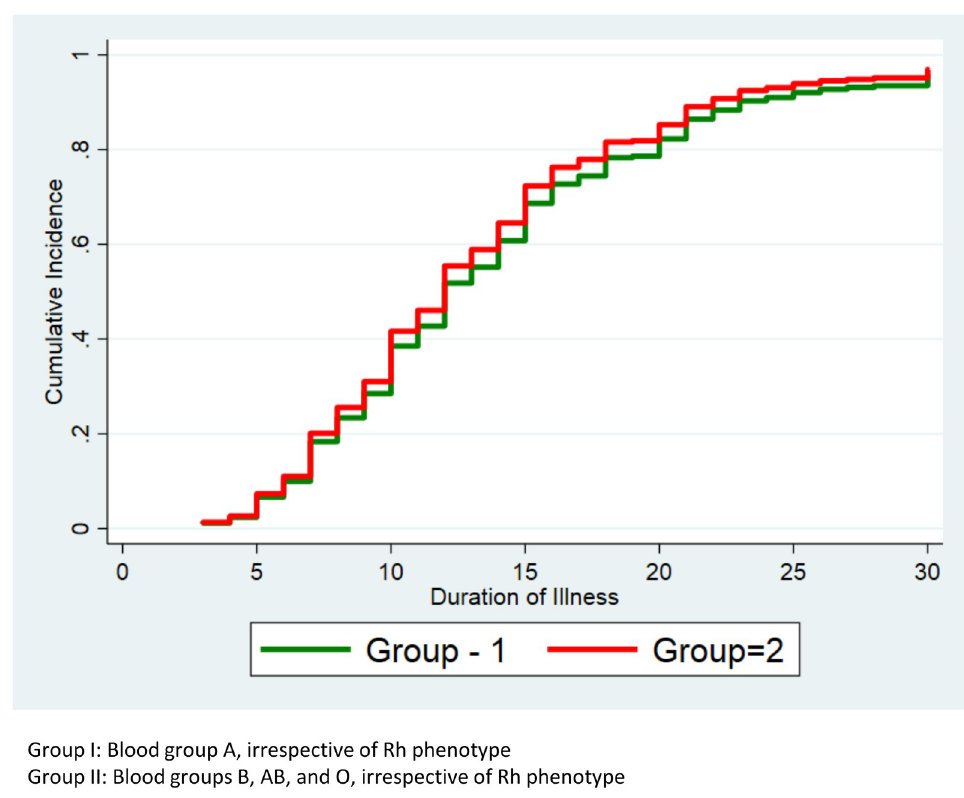
Fig 2. Cumulative incidence by blood group from Fine-Gray